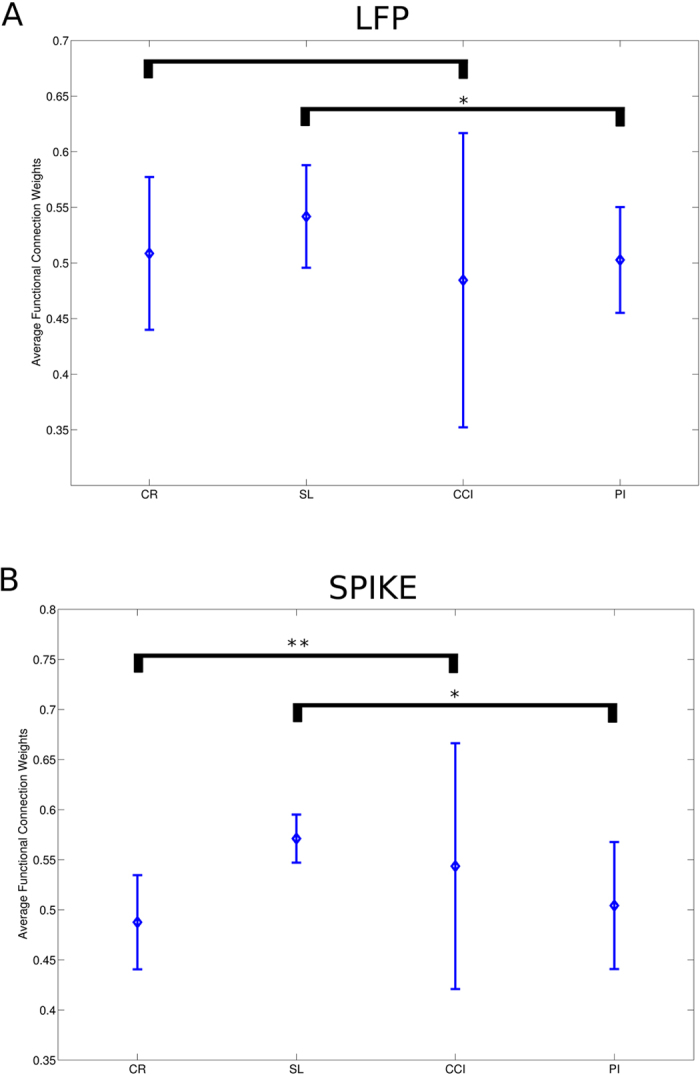
Comparison among the experimental conditions.(A) Average graph weights (obtained from LFP) did not statistically differ from normal to neuropathic models. Similarly, graph weights from spiking activity produce the same result. CR represents the control, PI the peripheral injury, the SC the sciatic constriction (Bennet-Xie model) and the SL (Seltzer model) animals. Lines outgoing the central balls indicate the standard deviation.